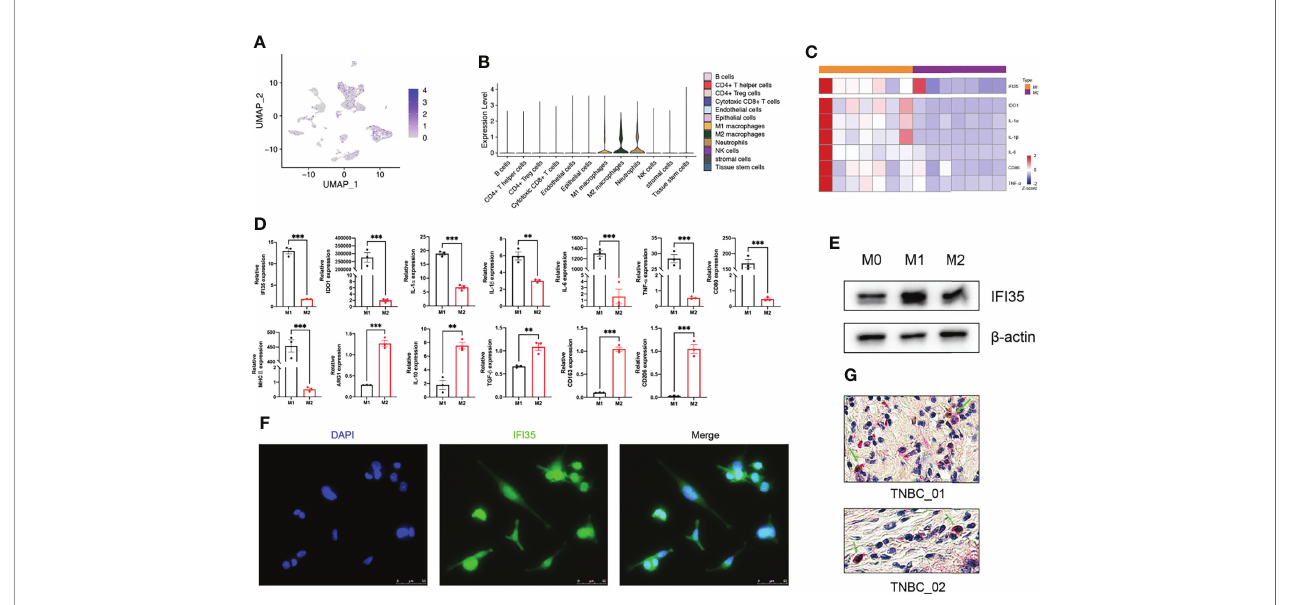
FIGURE 8 | M1 polarization of macrophages upregulated IFI35 expression. (A, B) , UMAP and violin plots of IFI35 expression level in each cluster. (C) , Heatmap showing differential expression of M1 classical markers and IFI35. (D) . qRT-PCR analysis of typical M1 and M2 polarization markers and IFI35 expression in macrophages with different stimuli as indicated. (E) , Levels of IFI35 in M0, M1 and M2 macrophages. (F) , Representative immuno fl uorescence images of M1 macrophages stained with DAPI (DNA) and anti-IFI35 antibody. (G) . Representative double-labeling IHC images (200×) of TNBC sections stained with CD86 (Brown) and IFI35 (Red). Experiments were performed with at least three biological replicates, and data shown are representative of at least three independent experiments. Data are presented as mean ± SEM. **p < 0.01; ***p <